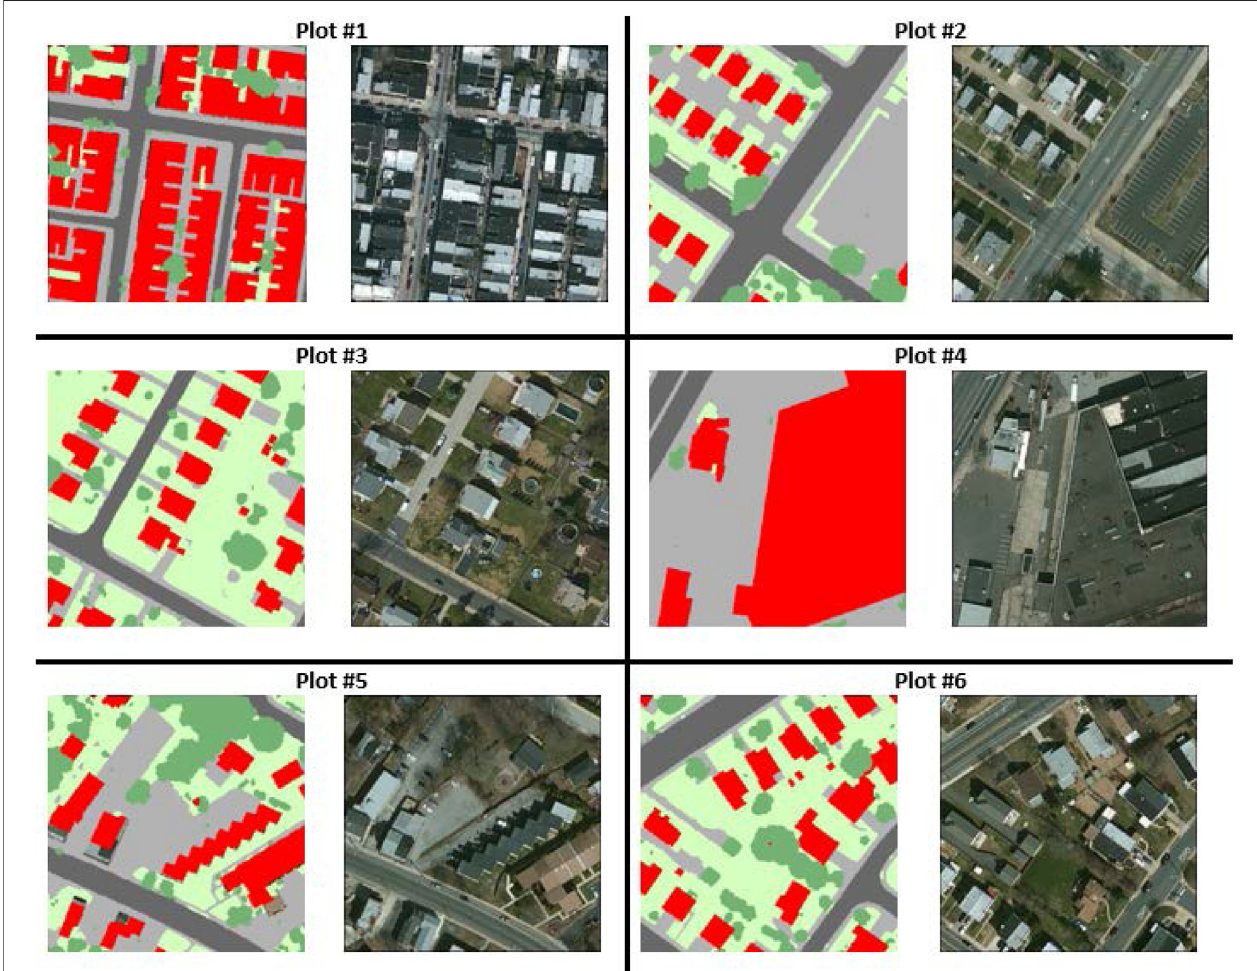
FIGURE 3 | Example of the composition of STURLA grid cells of the most common STURLA class in Philadelphia “ tgpl ” . STURLA “ tpgl ” cells are shown next to corresponding areal imagery.